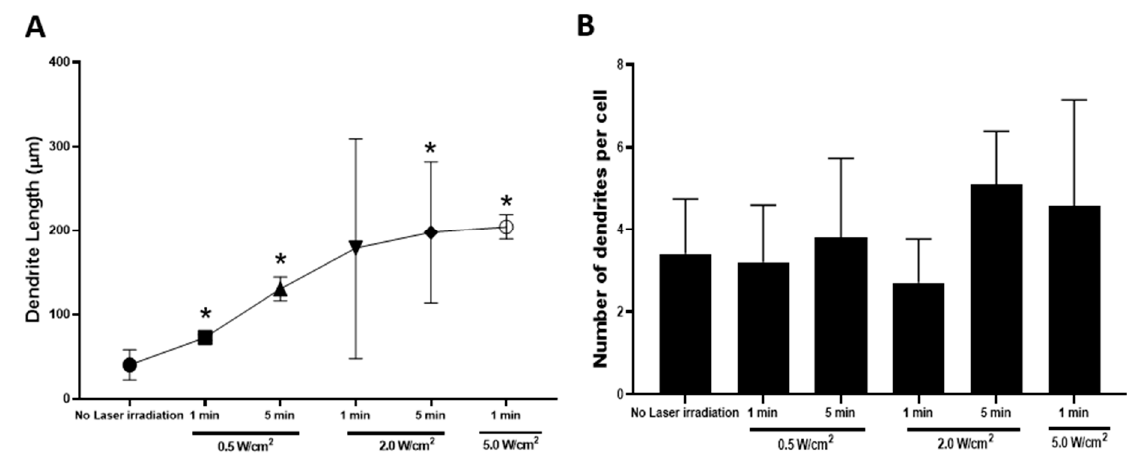
Figure 4. Assessment of the number and length of dendrites in differentiated neurons. rNSCs were seeded onto laminin- coated AuNC-aECMs, and after 2 days, cells were treated with indicated laser irradiation parameters (0.5–5.0 W/cm 2 for 1–5 min). After 14 days, cells were analyzed with immunocytochemistry. The immunostaining images were analyzed with a custom-made MATLAB script to quantify the length and number of neuronal dendrites ( A , B ). Values represent the means ± SDs of three independent experiments. * p < 0.05 vs. laminin-coated AuNC-aECM in the absence of laser irradiation group.